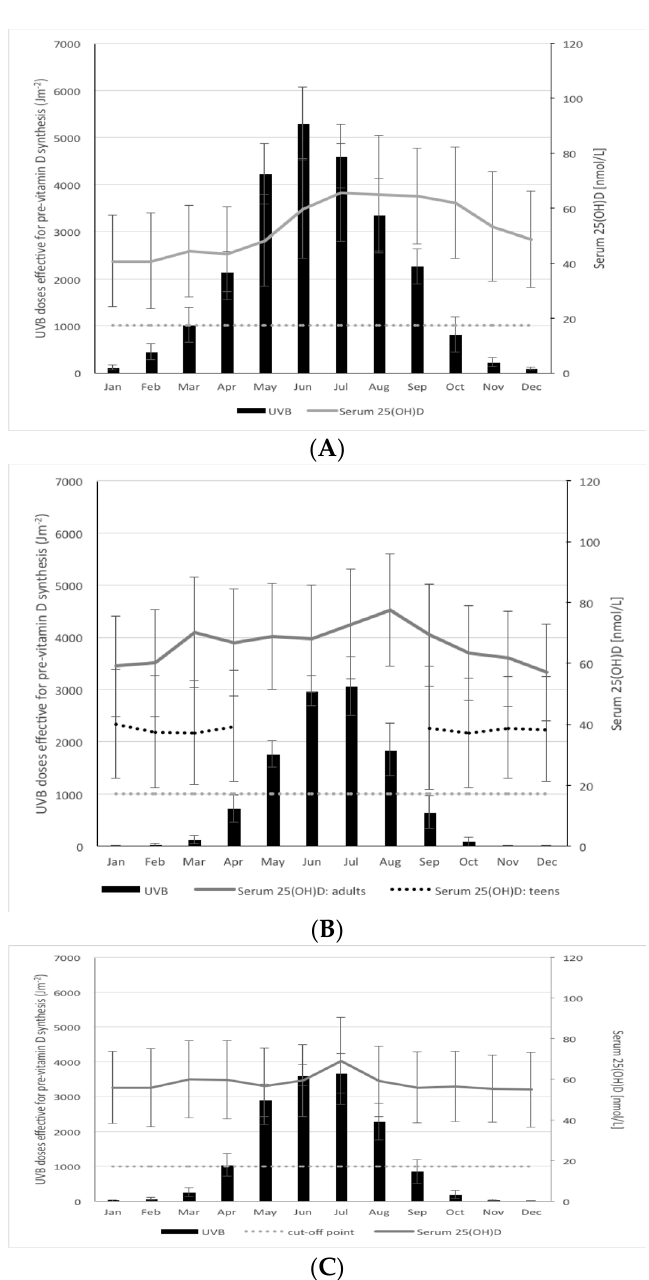
Figure 4. Mean modeled UVB doses effective for pre ‐ vitamin D 3 synthesis (Jm − 2 ) on a monthly basis in a typical year (mean of 2003–2012) in Ireland (51–54° N) and mean (SD) monthly serum 25(OH)D measured in adults (18–84 years) in the National Adult Nutrition Survey in Ireland [21] ( A ); in Tromsø, Northern Norway (69° N) and mean (SD) monthly serum 25(OH)D measured in adults (18–83 years) in the regionally representative Tromsø sixth cycle cohort [17] (solid line) and adolescents (15–18 years) in the Tromsø—Fit Futures study [18] (dotted black line) ( B ); and in Reykjavik, Iceland (64° N) and mean (SD) monthly serum 25(OH)D measured in adults (aged 66–96 years) in the regionally representative AGES ‐ Reykjavik cohort in Iceland [19] ( C ). Note: Data on serum 25(OH)D for the four summer months (May to August) are absent in Tromsø—Fit Futures study as the adolescents were not sampled in this period due to school summer vacation. Dotted line reflects a threshold of 1000 Jm − 2 as a guide to a dose below which dermal synthesis of pre ‐ vitamin D 3 is relatively low. Black bars and error bars represent mean and SD monthly UVB doses, respectively.